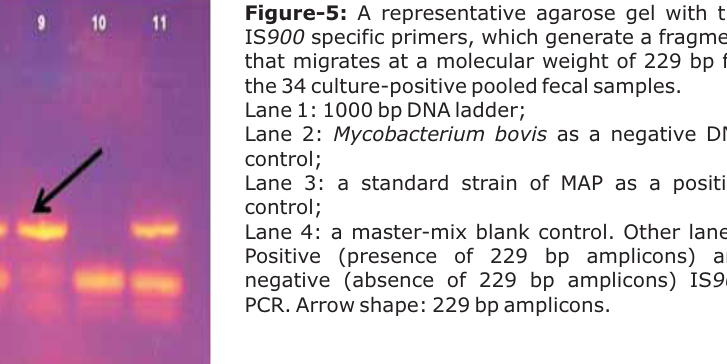
Table-3: Overall detection of MAP by culture and IS PCR. Out of 50 pooled fecal samples, 34 (68%) were culture positive of which 18 isolates (52.94%) were positive for the IS PCR. The numbers of positivity in each animal spp. of each governorate were indicated.